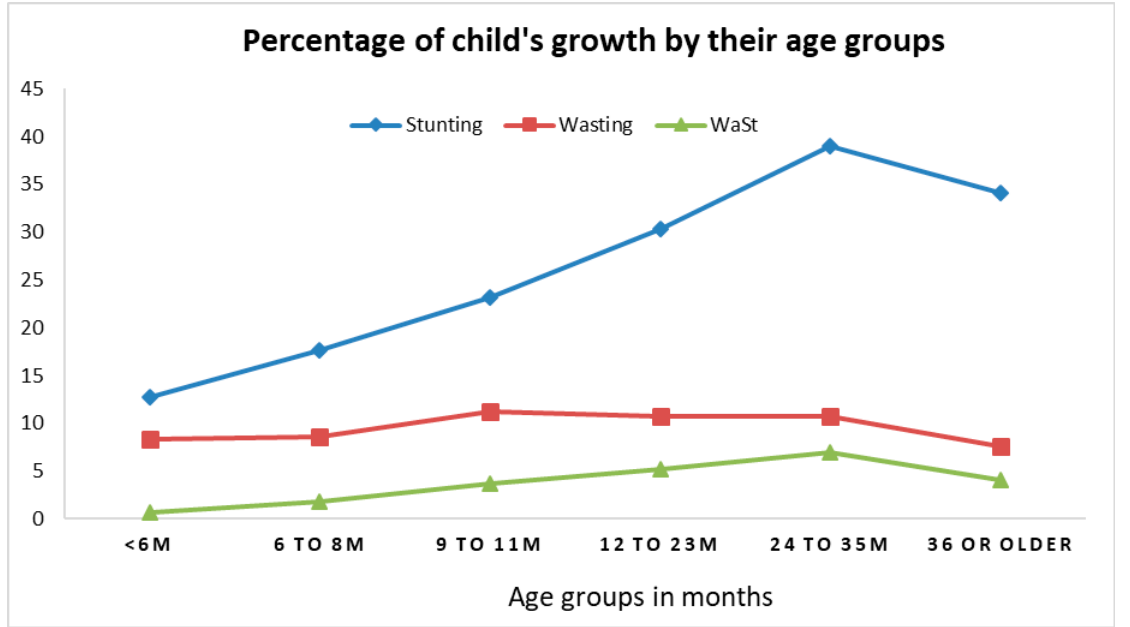
Figure 2. Percentage of child growth by age group from the 1st to 6th follow-up (n = 1079; observations = 5984). Stunting = height-for-age Z score < − 2 standard deviation; Wasting = weight-for-height Z score < − 2 standard deviation; and WaSt = concurrence wasting and stunting.